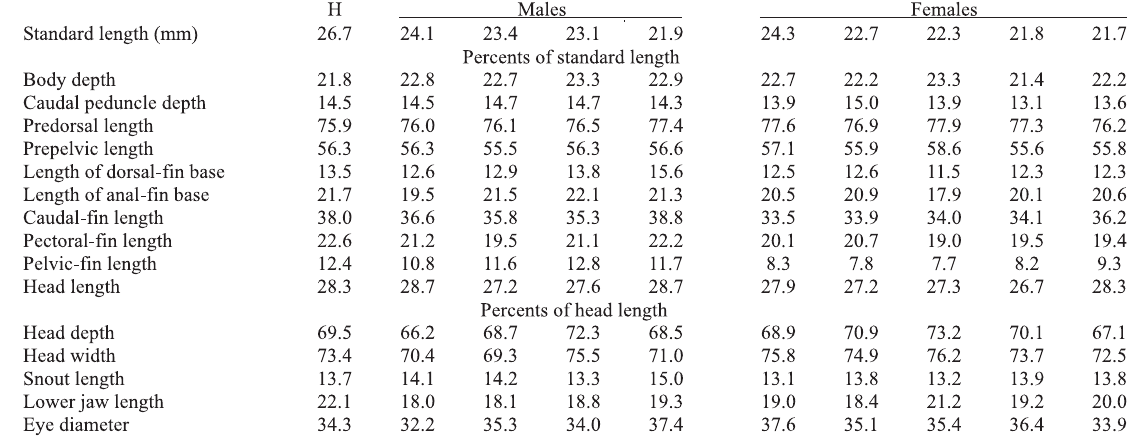
Infraorbital region and ventral surface of head white. Lower jaw reddish gray. Iris light yellow. Dorsal fin yellow with four dark gray bars; broad dark gray to black distal stripe. Anal fin light yellow, base blue with five short red bars; broad dark gray to black distal stripe. Caudal fin light yellow with four or five dark gray bars; sometimes parts of some bars broken forming elongate spots; black spot on subdorsal portion of caudal fin base; dark gray stripe posterior to black spot, some- times inconspicuous; caudal fin margins black. Pelvic fin pale yellow, anterior margin dark gray to black. Pectoral fin yellow- ish